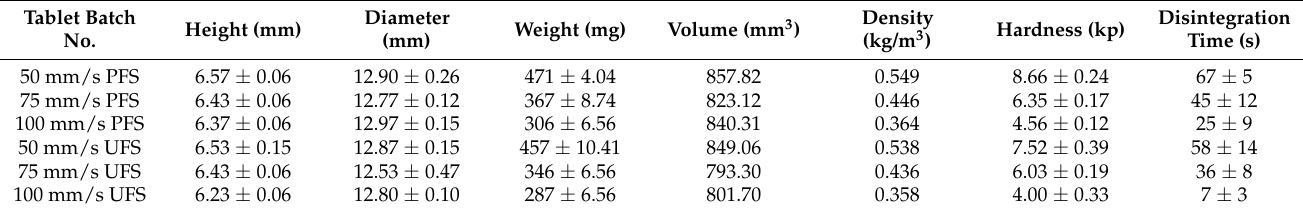
Table 1. Quality attributes of 3D printed tablets using PFS and